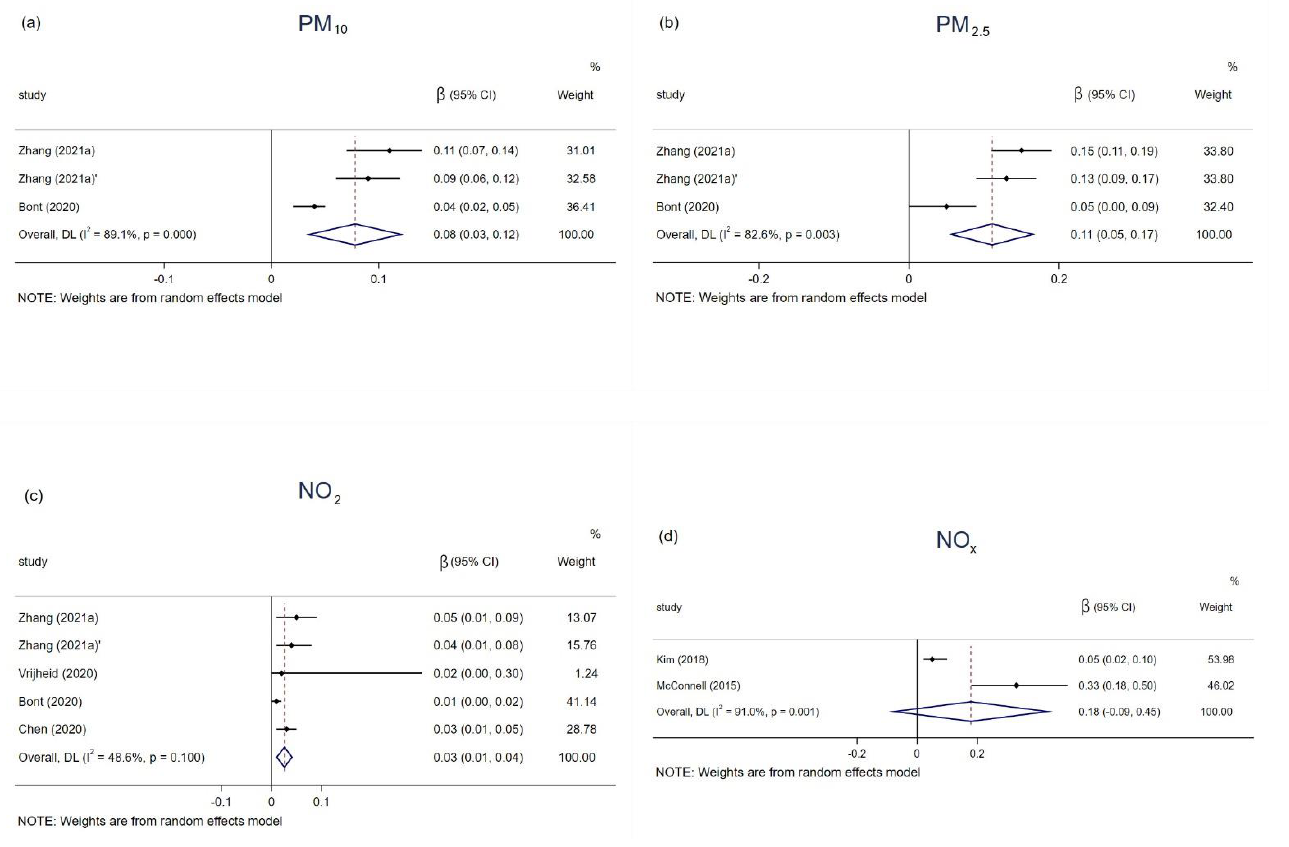
Figure 3. Associations of PM 10 ( a ), PM 2.5 ( b ), NO 2 ( c ), and NO x ( d ) with BMI in children and ado- lescents.